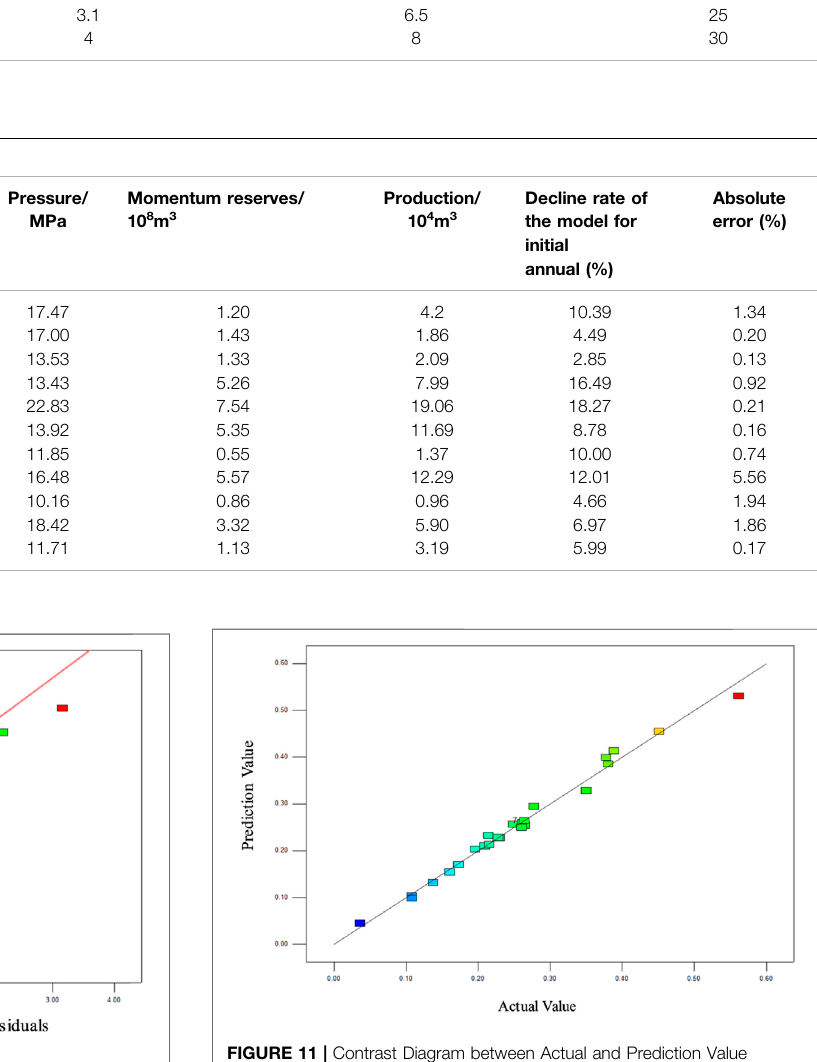
FIGURE 10 | Normal probability distribution of residuals